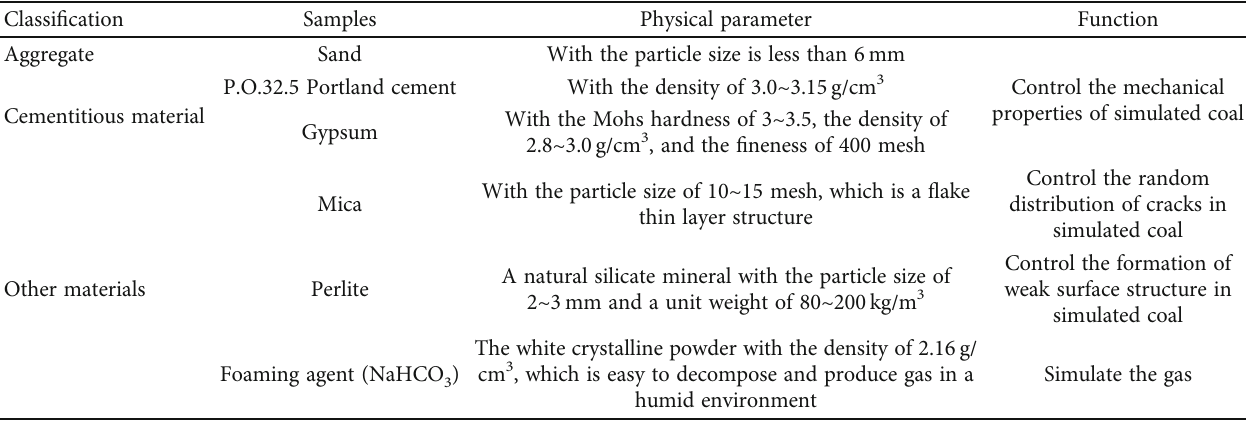
Table 1: Physical properties and functions of test materials.